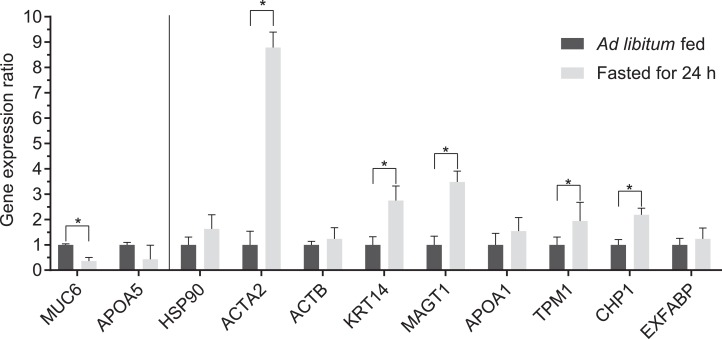
Relative quantification of mRNA of genes encoding the differentially expressed proteins.Relative expression was determined by qPCR and data are presented as group means, error bars represents ± SEM (with n = 8 in each group). *Indicates statistically significant difference between groups (P < 0.05). The vertical line separates between downregulated (left) and upregulated (right) protein spots compared to ad libitum fed group.